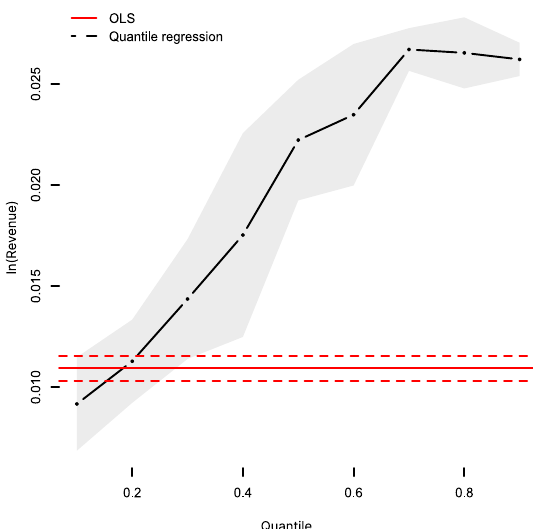
Figure 3. The slope coefficients for the different quantiles of revenue distribution for Asian Russian timber enterprises. The red dotted line as well as the grey area represent the confidence intervals. The black dots on the Figure 3 reflect the slope coefficients for each decile of revenue distribution. These coefficients vary greatly across the quantiles and, starting from